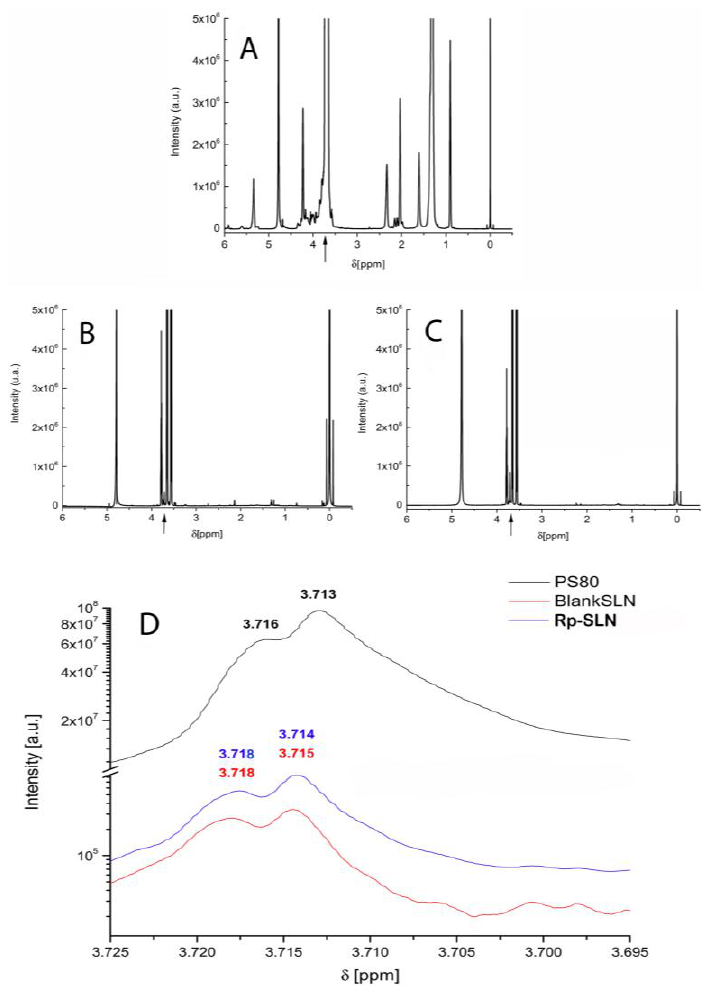
Figure 5. Proton nuclear magnetic resonance spectroscopy ( 1 H NMR) spectra of ( A ) PS80, ( B ) blank and ( C ) Rp-SLN all prepared in D 2 O, were submitted to an external magnetic field of 18.8 T and 1 H resonance frequency of 800 MHz. The arrows indicate the area magnified in ( D ) corresponding to the PS80-derived oxyethylene moiety signals (about δ = 3.7) to highlight the slight shift occurring in SLN compared to pure PS80.